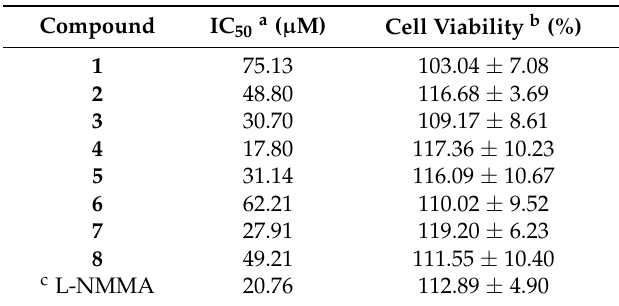
Table 2. Effects of compounds 1 – 8 on NO production in LPS-activated BV-2